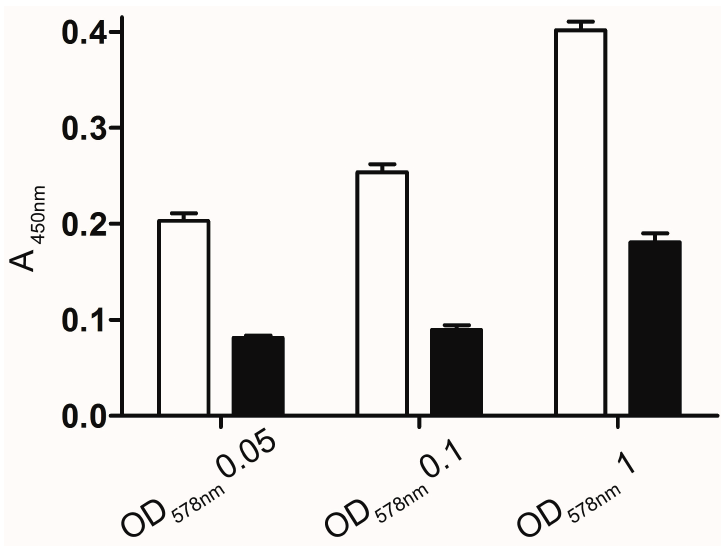
Figure 2. Whole cell enzyme-linked immunosorbent assay (ELISA). White: E. coli F470 cells containing pAK009 for surface displaying of Hyal-1. Black: E. coli F470 cells without plasmid. Wells of a Maxisorp ® 96-plate were coated with cell suspensions of various optical densities at 578 nm (OD 578 ) of 0.05; 0.1 and 1. After labelling with the primary